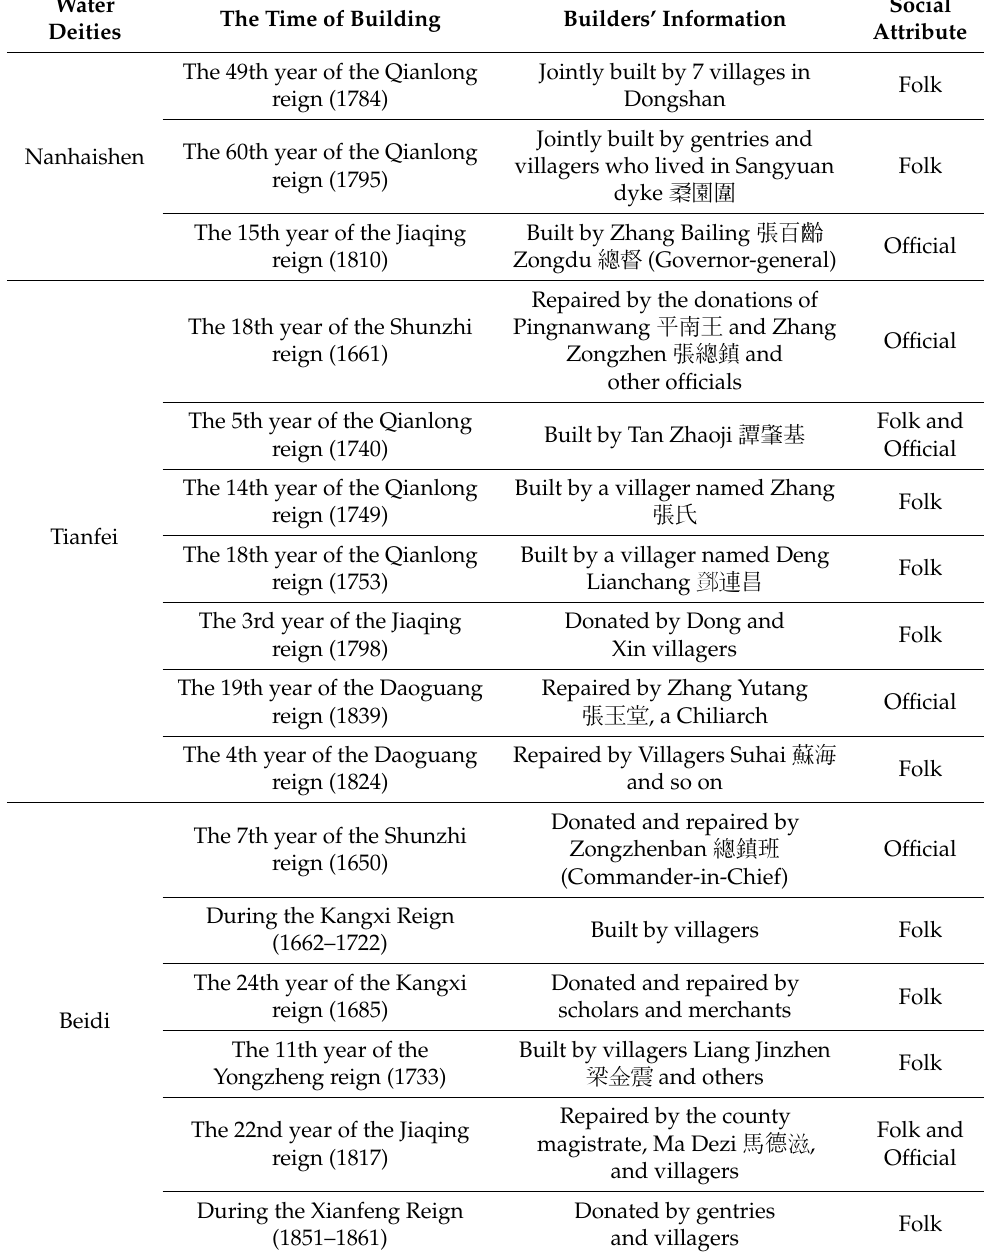
Table 3. The statistics on the temple builders and their identities in the Qing Dynasty.